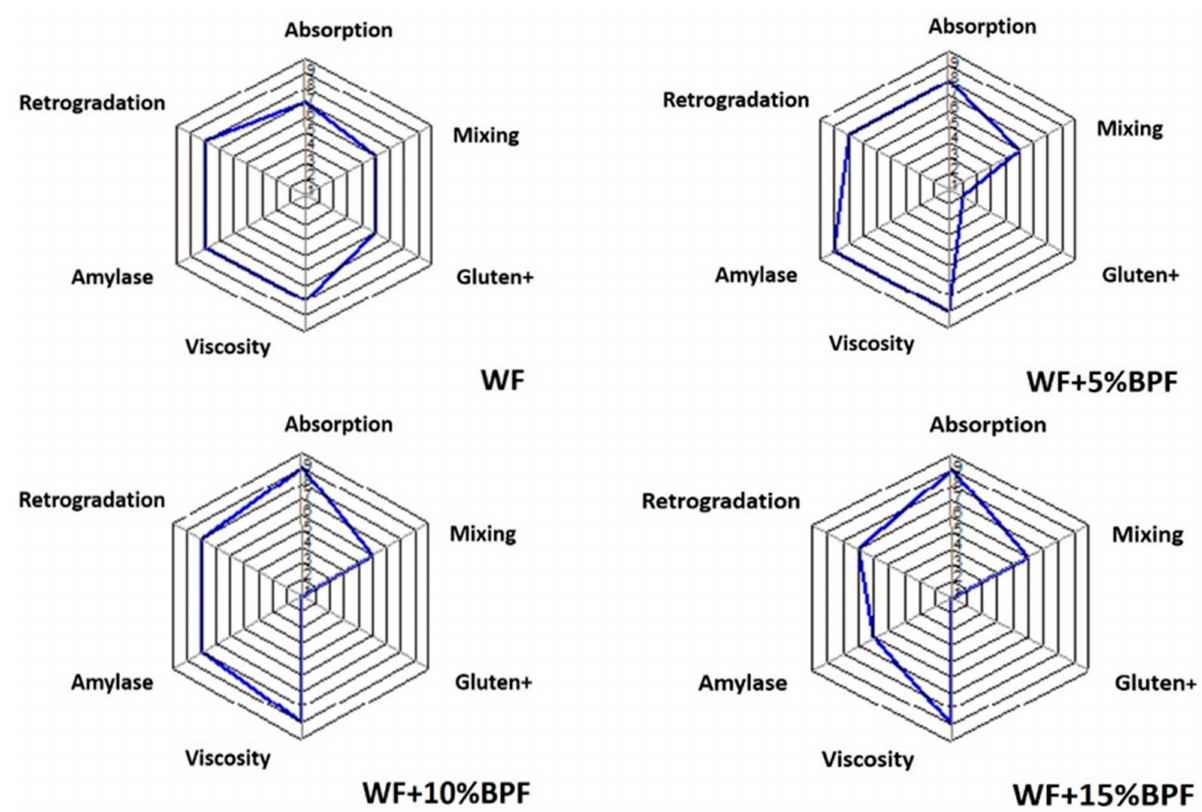
Figure 1. The Mixolab standard profile of WF 72% and substituted WF with BPF ( A. digitate ) at different substitution levels